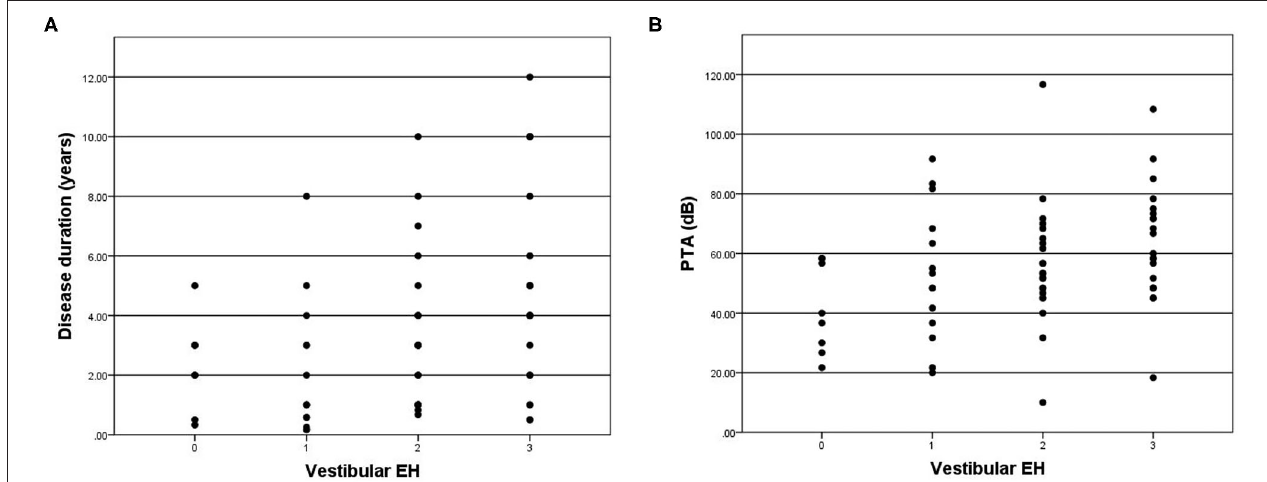
FIGURE 2 | (A) Correlation between grade of vestibular EH (x-axis) and disease duration (y-axis). The positive correlation is significant ( r = 0.360, p = 0.003). (B) Correlation between grade of vestibular EH (x-axis) and PTA (y-axis). The positive correlation is significant ( r = 0.326, p = 0.008).